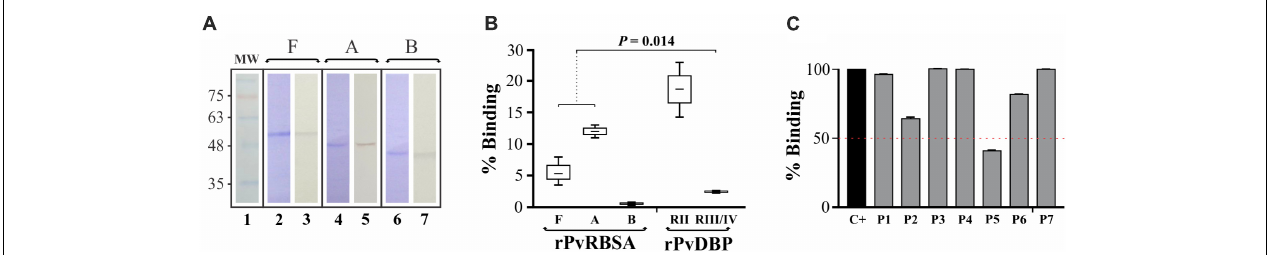
FIGURE 4 | PvRBSA reticulocyte binding activity. (A) Purification of full rPvRBSA (F) or its fragments (A and B). The Figure shows each purified molecule analysed by Coomassie blue staining (lines 2, 4, and 6) or Western blot (lines 3, 5, and 7). MW, molecular weight marker (line 1). (B) rPvRBSA target cell binding assay. DBP-RII and -RIII/IV indicates positive and negative binding controls, respectively. (C) Binding inhibition assay. The Figure shows the rPvRBSA reticulocyte binding inhibition percentage using different PvRBSA-A-derived peptides as well as a M. tuberculosis peptide (negative controls). Standard deviation is shown for each assay. C+,